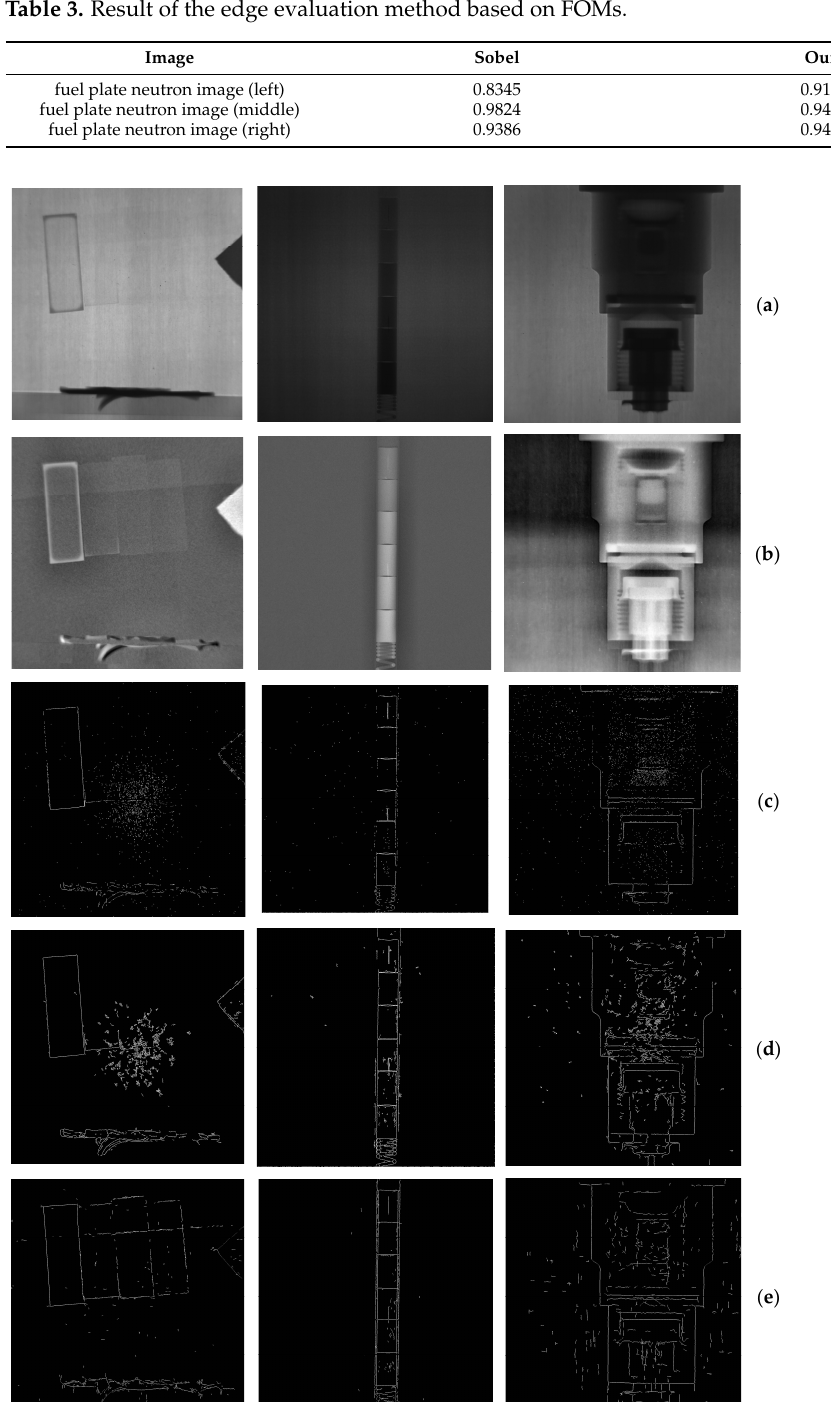
Figure 6. The ground truth images of plate nuclear fuel elements obtained by Canny for FOM eval- uation: ( a ) left; ( b ) middle; ( c ) right. Table 3. Result of the edge evaluation method based on FOMs. Image Sobel Ours